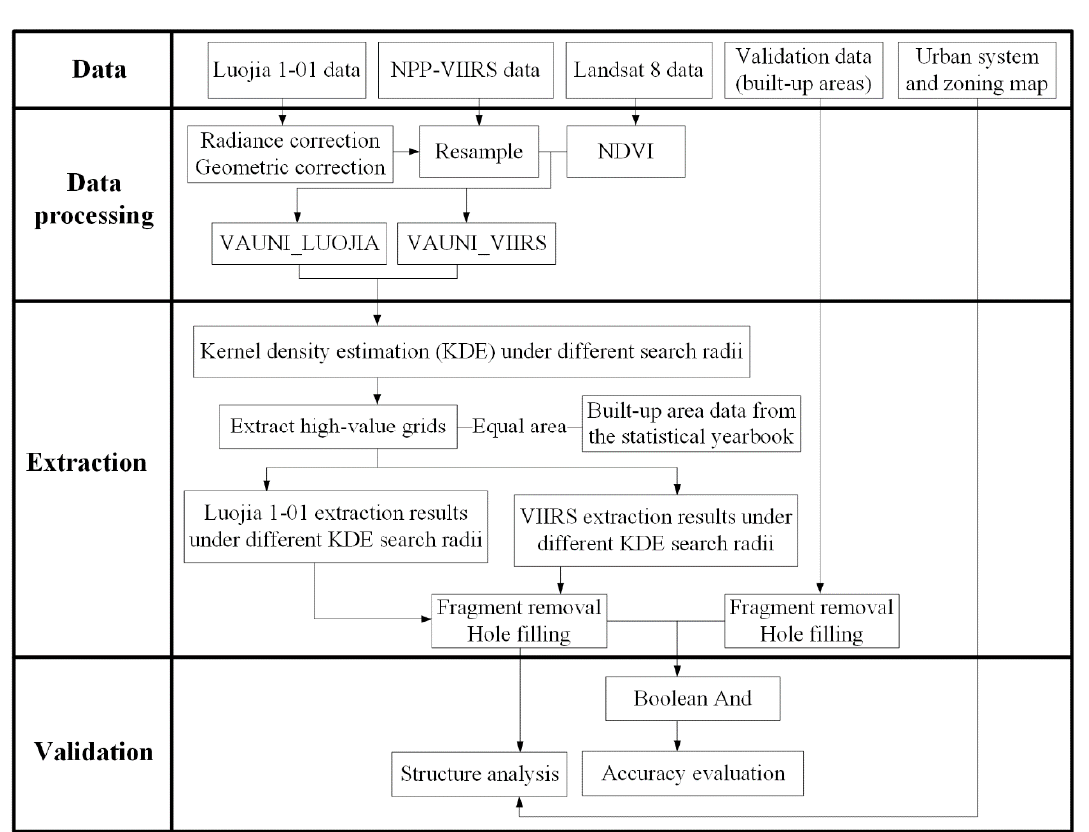
5 of 17 Figure 2. Validation maps of the structure of Nanjing city represented as: ( a ) the zoning mapissued by Jiangsu Provincial Bureau of Surveying Mapping and Geoinformation; ( b ) the urban system map derived from the plan of the Nanjing Jiangbei New District Administrative Committee and the Nanjing Urban Master Plan (2011–2020) issued by Nanjing Municipal Planning and Natural Resources Bureau; ( c ) the built-up area of Nanjing in 2018 from the Resource and En- vironment Data Cloud Platform. 2.2. Analytical Methods